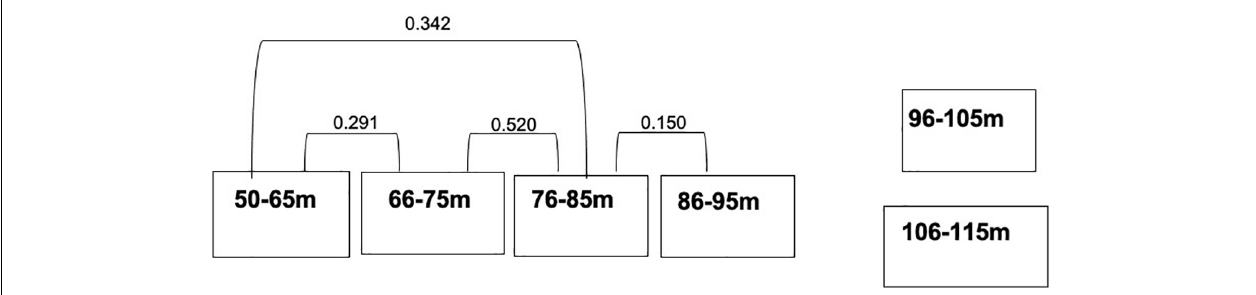
FIGURE 7 | Multi-response permutation procedure relationships for the depth domains. Connected depth types are not significantly different from one another in terms of their fish assemblages. P -values between the substrate categories are next to the connecting lines.